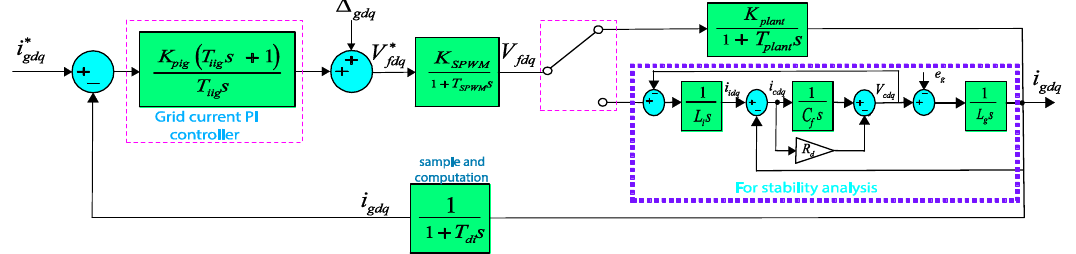
Figure 3. Design of the PI controller current loop of grid side converter.